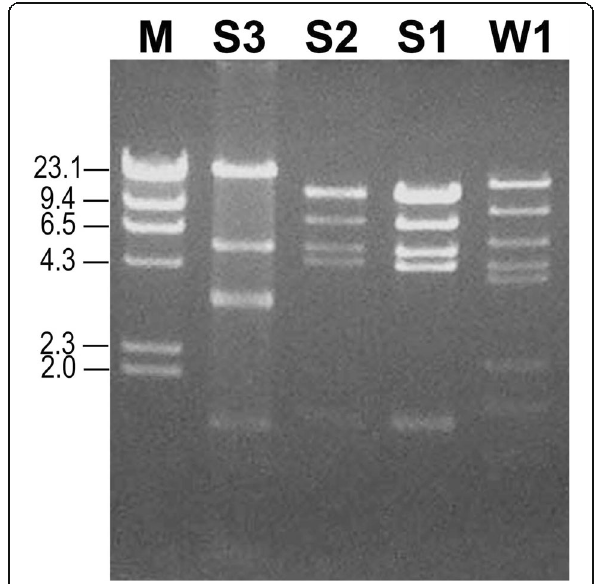
Fig. 3 Restriction fragment patterns of Eco RI-digested mitochondrial DNA of Acanthamoeba sp. strains CJY/S1, CJY/S2, CJY/S3, and CJY/ W1. The DNA fragments were separated on 0.7% agarose